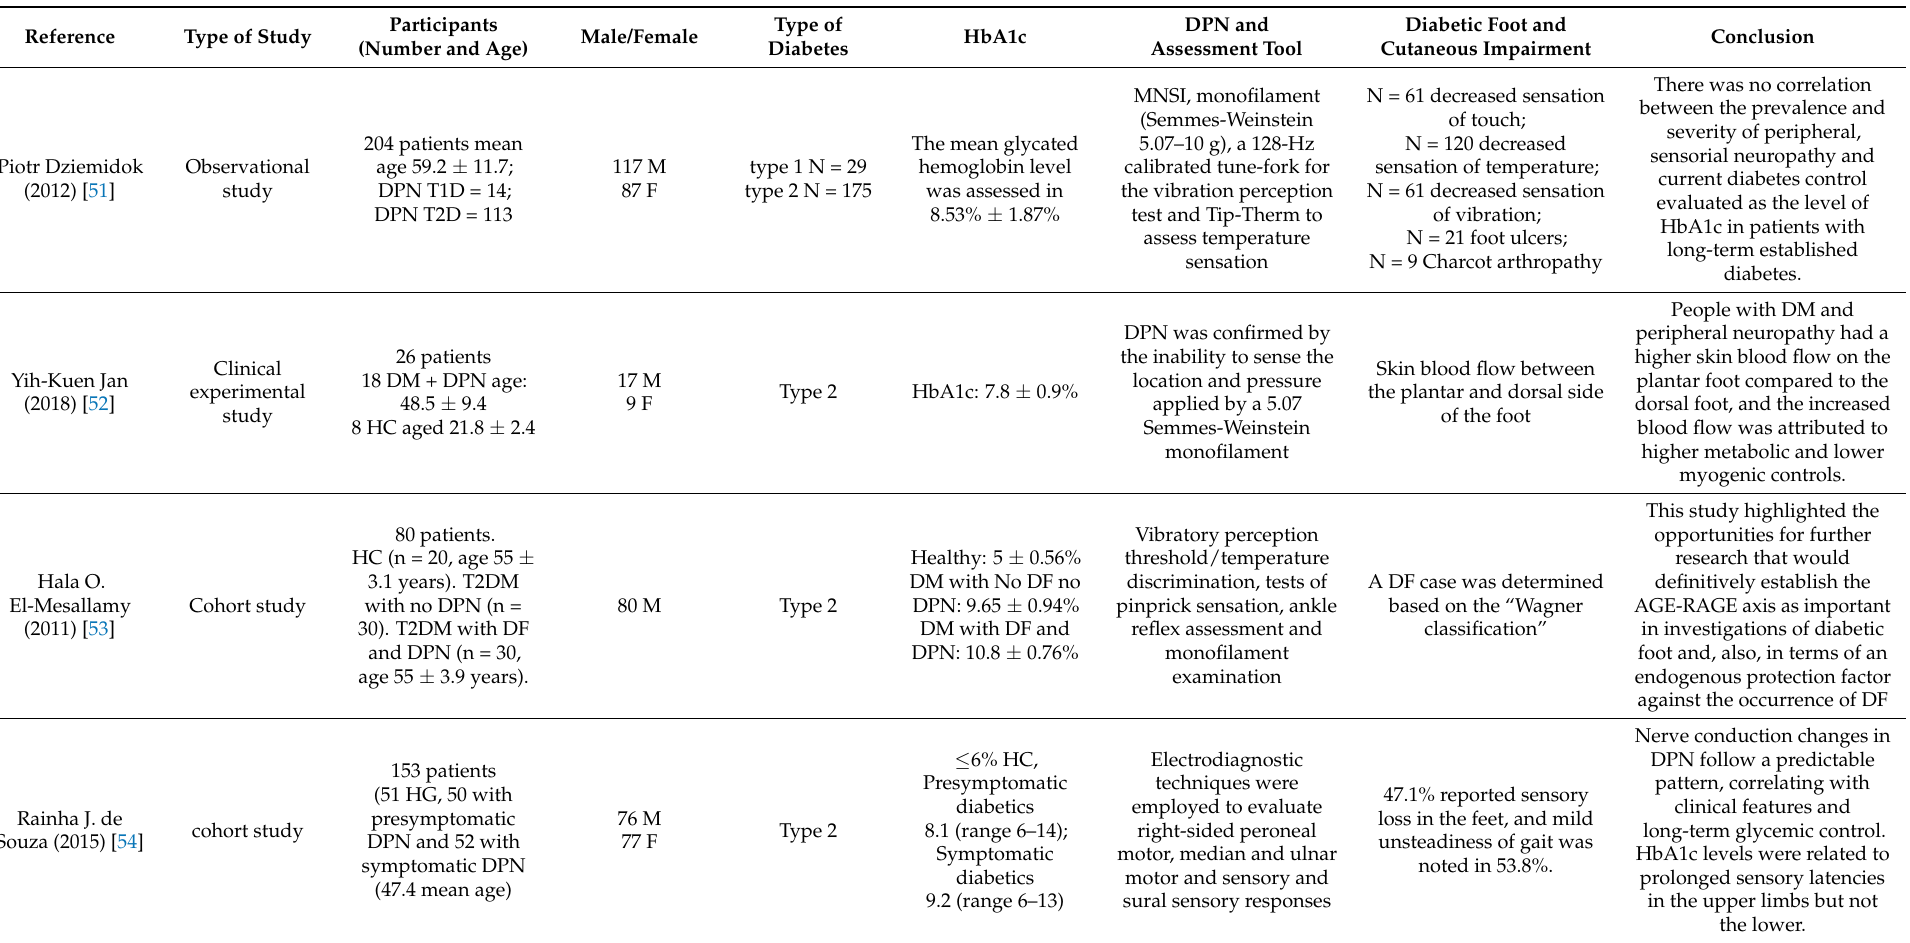
Table 1. Studies examining the usefulness of hemoglobin A1c (HbA1c) as a biomarker for the early detection of diabetic peripheral neuropathy (DPN) and foot impairment. In this table, we excluded studies that did not report HbA1c values or did not assess the prevalence of a diabetic